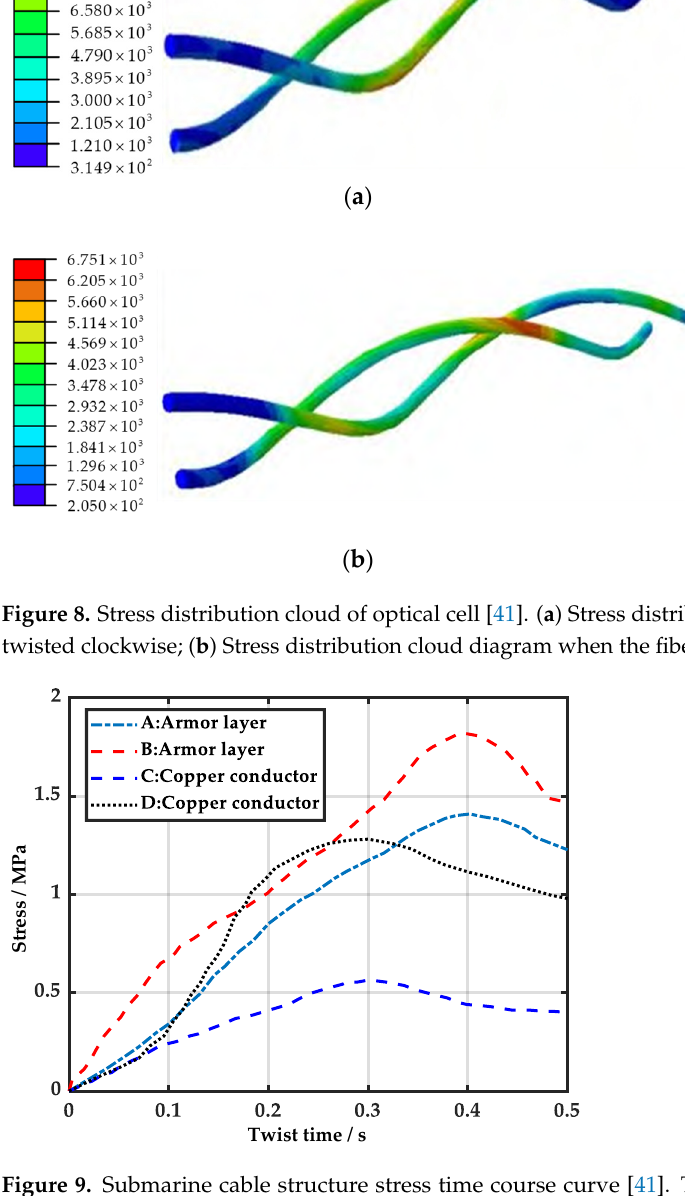
Figure 9. Submarine cable structure stress time course curve [41]. The A curve is the stress time course curve for the counterclockwise twisting of the armor layer. The B curve is the stress time course curve for the clockwise twisting of the armor layer. The C curve is the stress time course curve for the counterclockwise twisting of the copper conductor. The D curve is the stress time course curve of the copper conductor twisted clockwise.